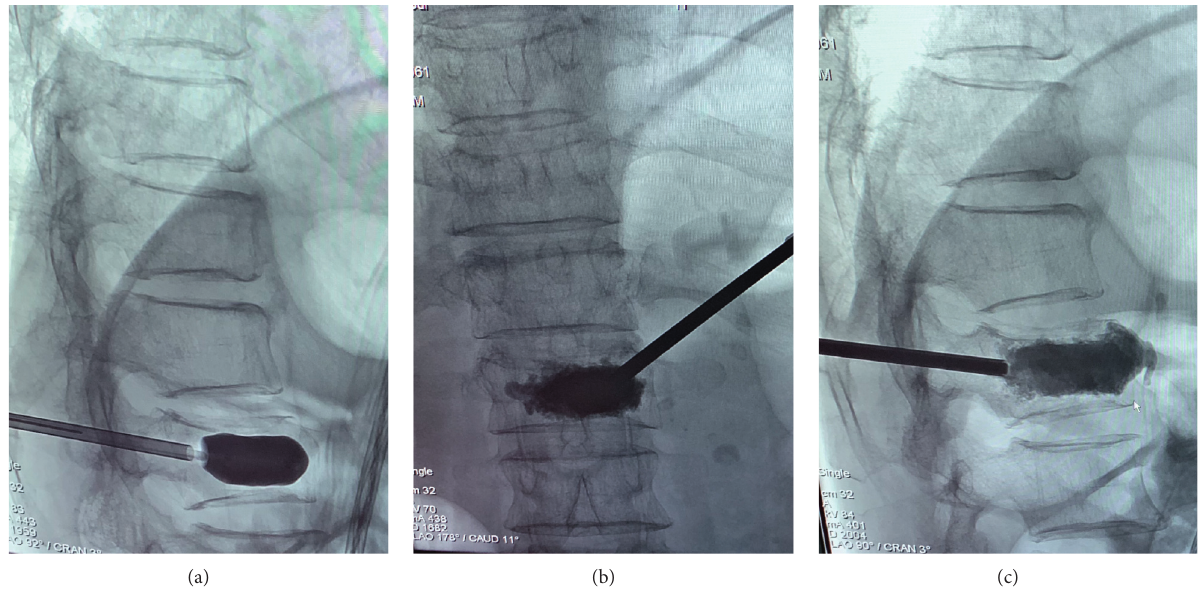
Figure 2: (a) The balloon was inflated to restore the height of the fractured vertebra and to create a cavity within the vertebra. (b) Frontal fluoroscopy view when bone cement was injected into the fractured vertebra. (c) Lateral fluoroscopy view when bone cement was injected into the fractured